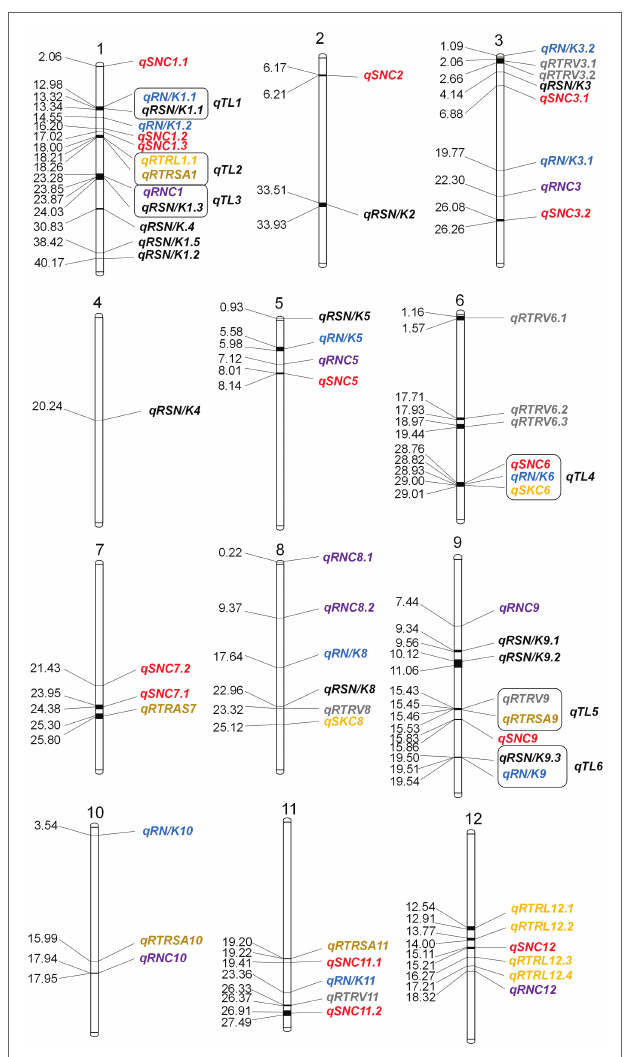
FIGURE 3 | Distribution of GWAS-based detected QTLs on 12 chromosomes in rice. Distances on the map are in